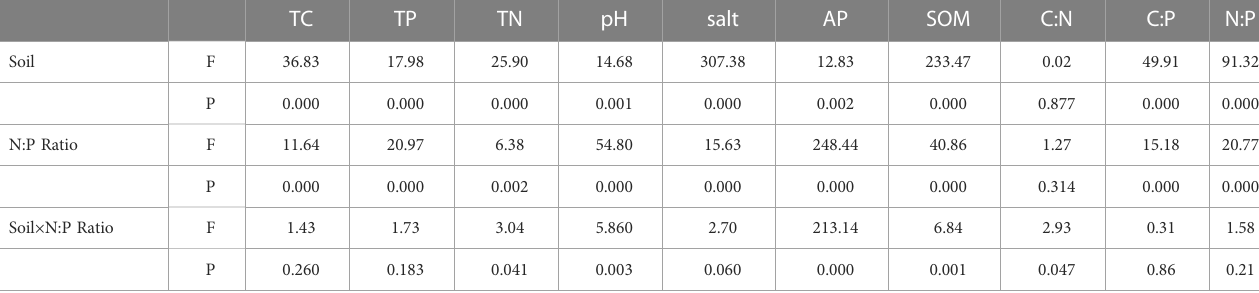
TABLE 5 Two-way ANOVA of the environmental factor of bacterial community.